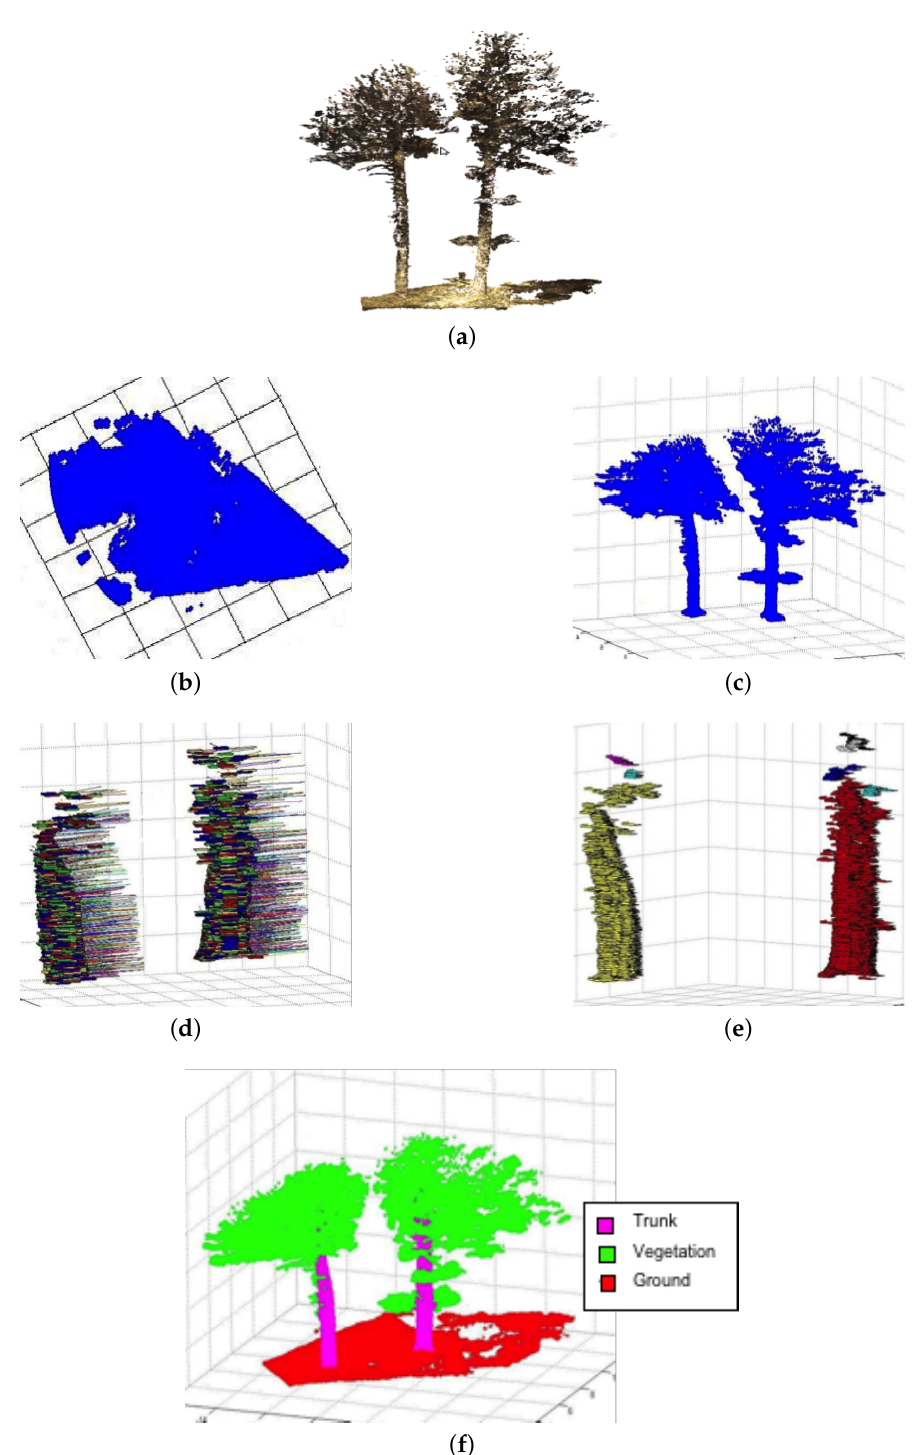
Figure 6. Segmentation and classification of Tree structure. In ( a ) the raw 3D point cloud. In ( b ), the 3D point cloud is represented in DEM while ( c ) is after ground segmentation/extraction. ( d , e ) show the tree trunk segmentation using a super-voxel based approach. In ( d ), it can be clearly seen that for a tree trunk the surface normals are predominantly horizontal. ( f ) shows the final classification